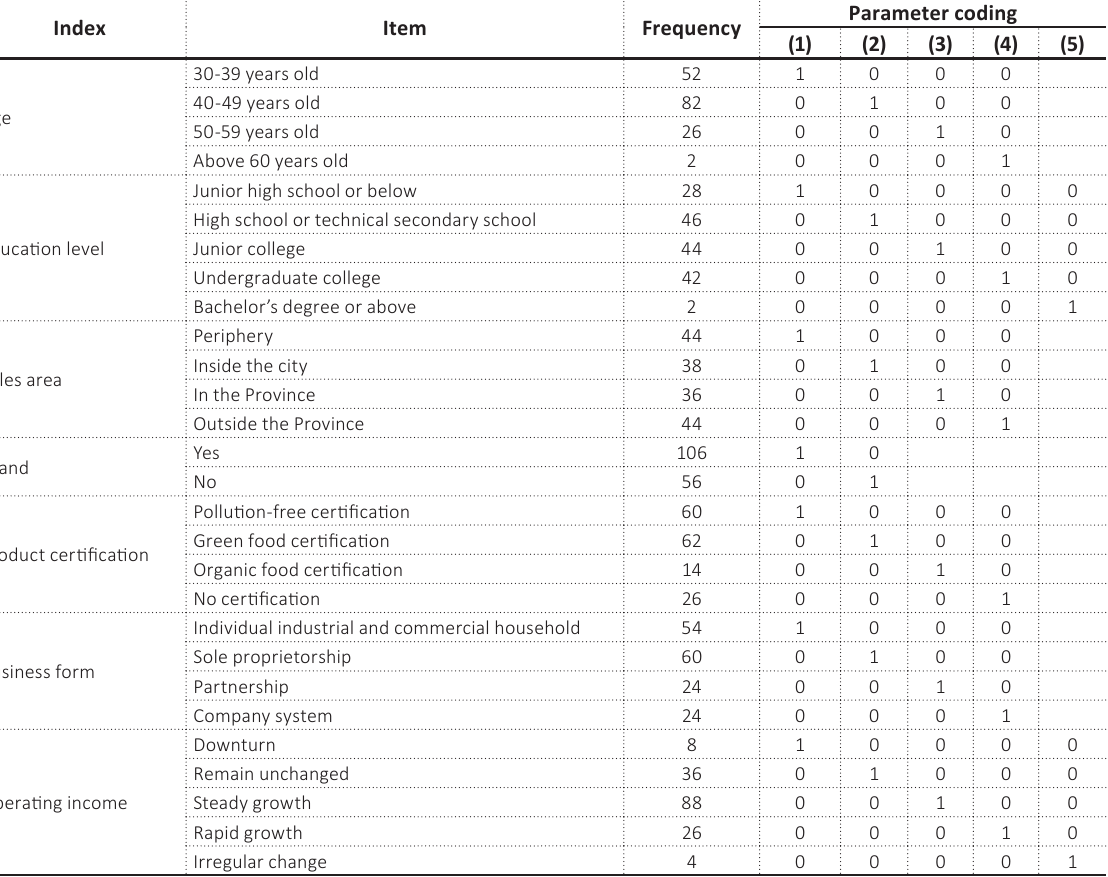
Table 1. Classification of variables’ codes